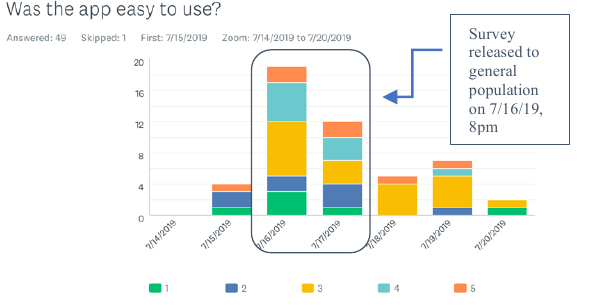
Figure 11. Time trend, Question 6. More respondents report the app being easy to use on 7/16 – 7/17.